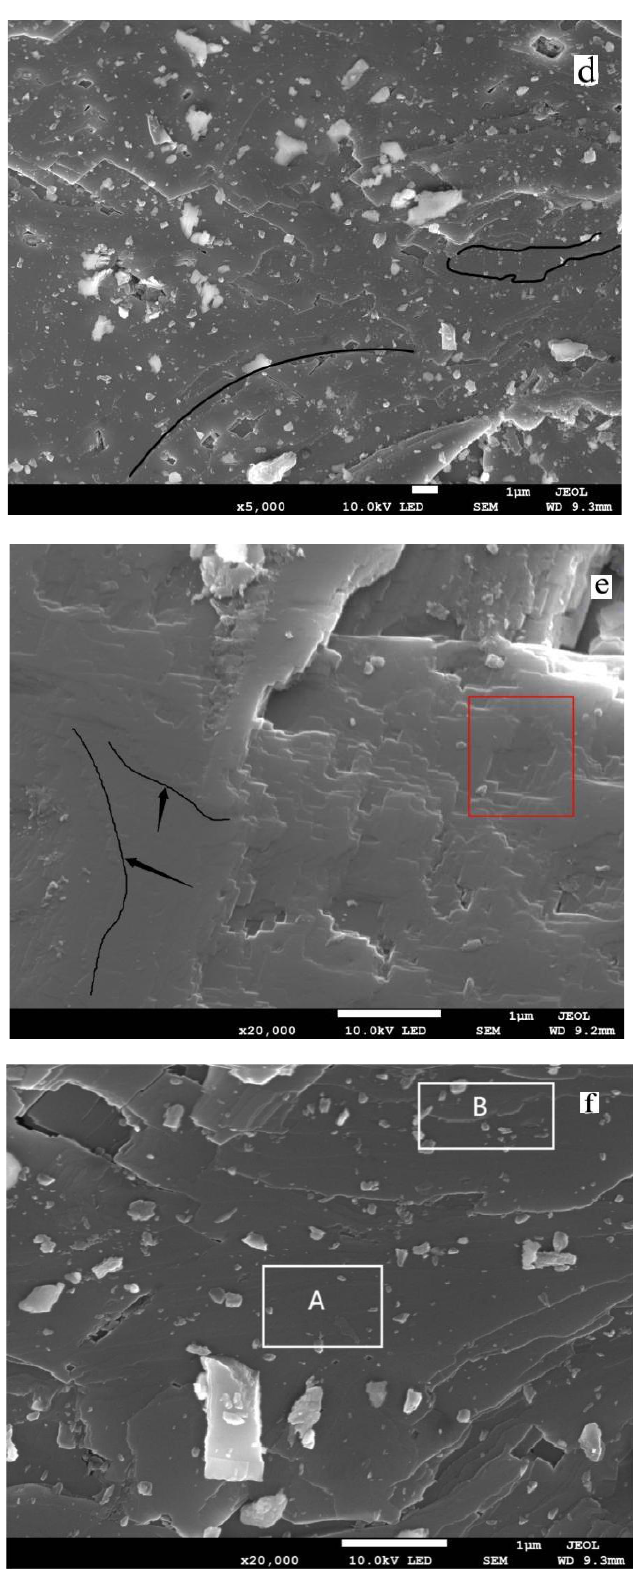
Figure 7. SEM images of dolomite surfaces: ( a , b ) Initial untreated dolomite; ( c ), dolomite after exposure to 1 mg/L PbCl 2 solution for 15 days; ( d ), dolomite after exposure to 50 mg/L PbCl 2 solutions for 15 days; ( e ), dolomite after exposure to 1 mg/L PbCl 2 solution with CO 2 for 15 days; ( f ), dolomite after exposure to 50 mg/L PbCl 2 solutions for 15 days surface energy spectrum zoning: A, relatively flat zone; B, step zone. Table 2. EDS spectra of dolomite surfaces after exposure to 50 mL of 1 mg/L PbCl 2 solution for 15 days. Element